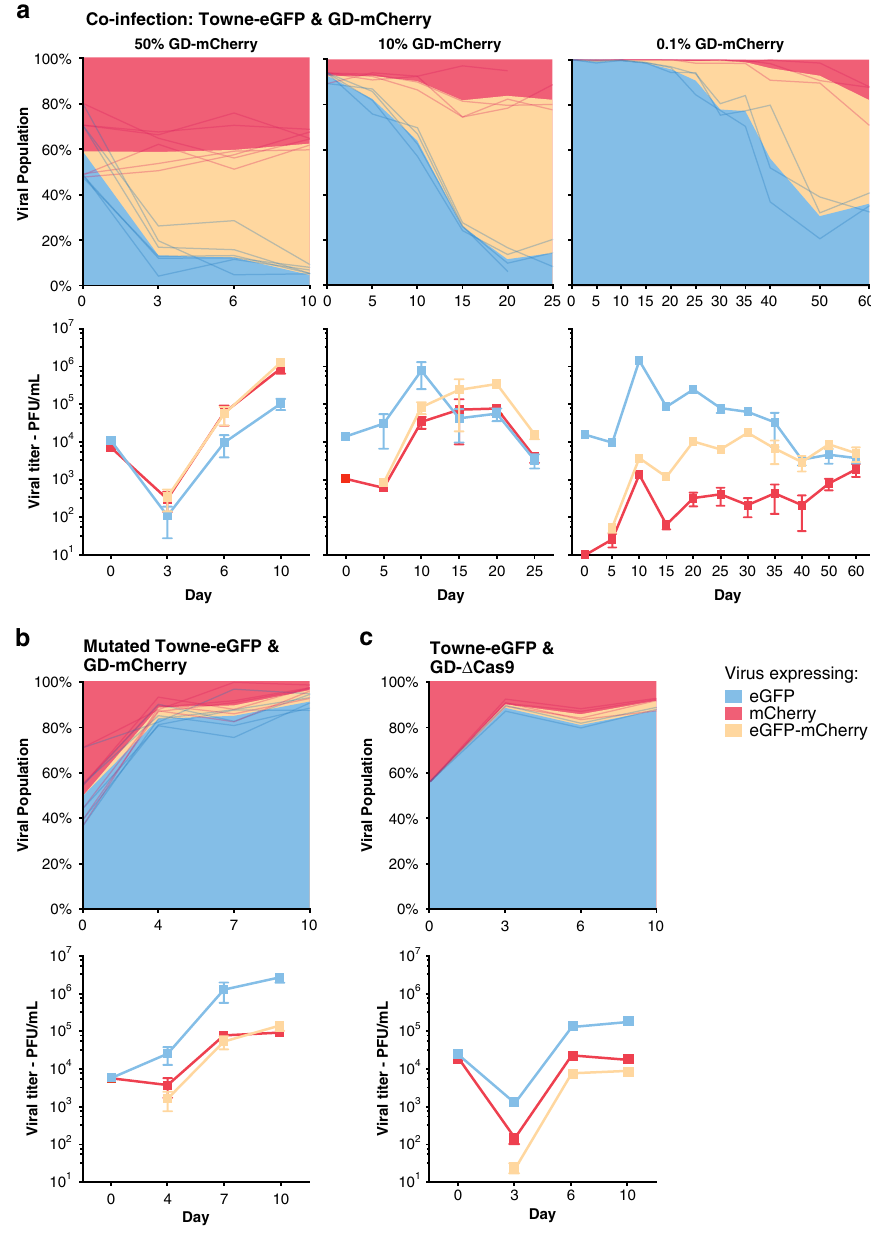
Fig. 4 Gene drive sequences ef fi ciently spread into the wildtype population. a Coinfection experiments between Towne-eGFP (MOI = 0.1 at day 0) and different starting concentration of GD-mCherry: Viral titers (lower panels) and proportion (upper panels) over time of viruses expressing eGFP alone, mCherry alone, or both as measured by plaque assay. Left panel: 50% of GD-mCherry at Day 0, n = 6; middle: 10% at D0, n = 4; right: 0.1% at D0, n = 3. b Viral titers and proportion of viruses after coinfection with equal amount of Towne-eGFP (with a mutated target site) and GD-mCherry. n = 6. c Viral titers and proportion of viruses after coinfection with equal amount of Towne-eGFP and GD- Δ Cas9. n = 3. Titers are expressed in plaque forming unit (PFU) per mL of supernatant. Error bars represent standard error of the mean (SEM) between biological replicates. In the panels representing the viral population, data show both the mean and the individual trajectory of biological replicates. Source data are provided as a Source Data fi